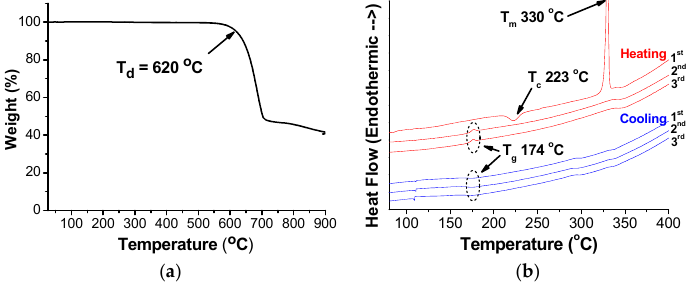
Figure 1. TGA ( a ) and DSC ( b ) thermograms of SimCP3 .